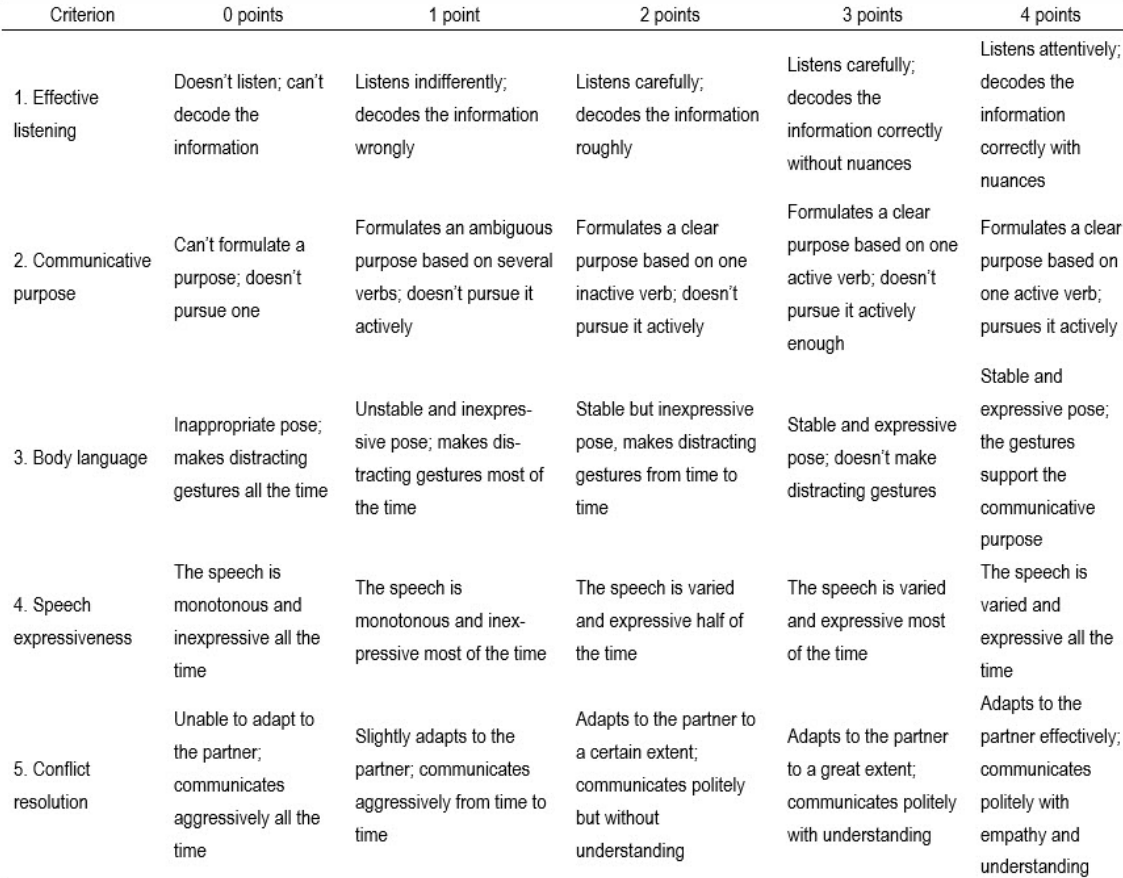
A criteria matrix for evaluating aspects of pupils’ communicative